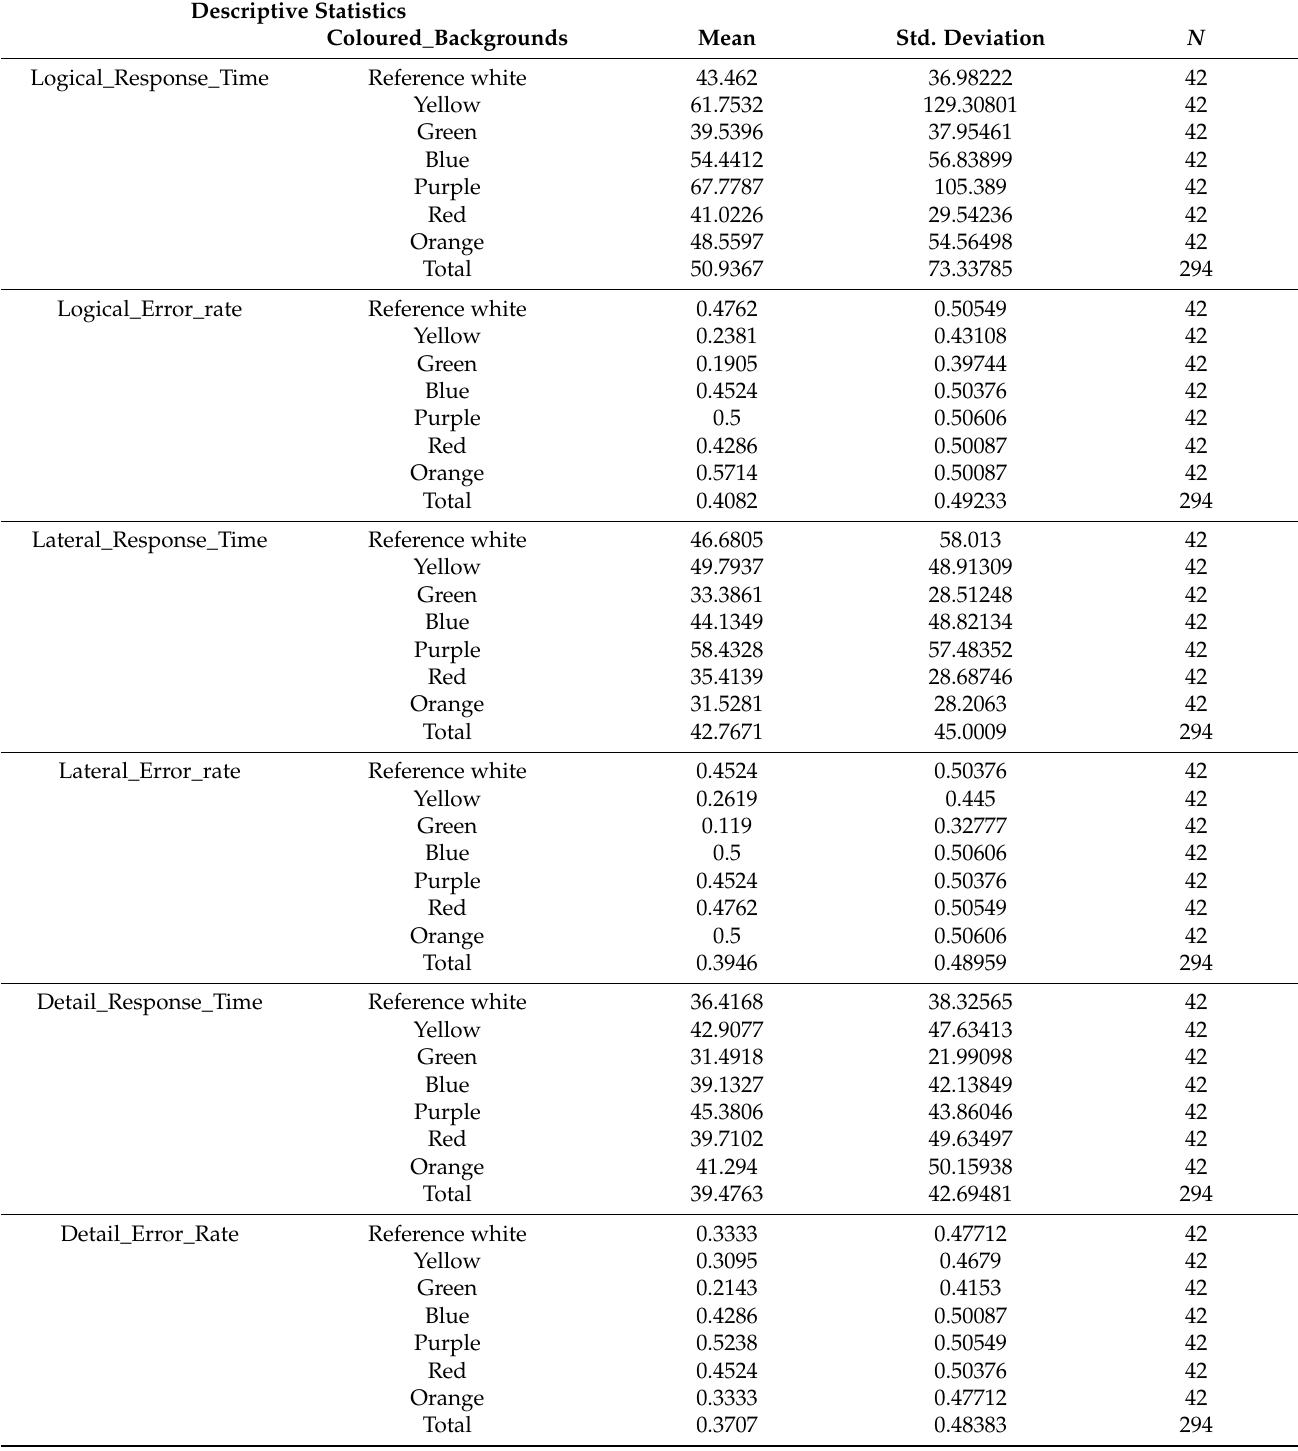
Table A6. MANOVO Analysis of People’s Logical, Lateral, and Detail Abilities Affected by Colours. Descriptive